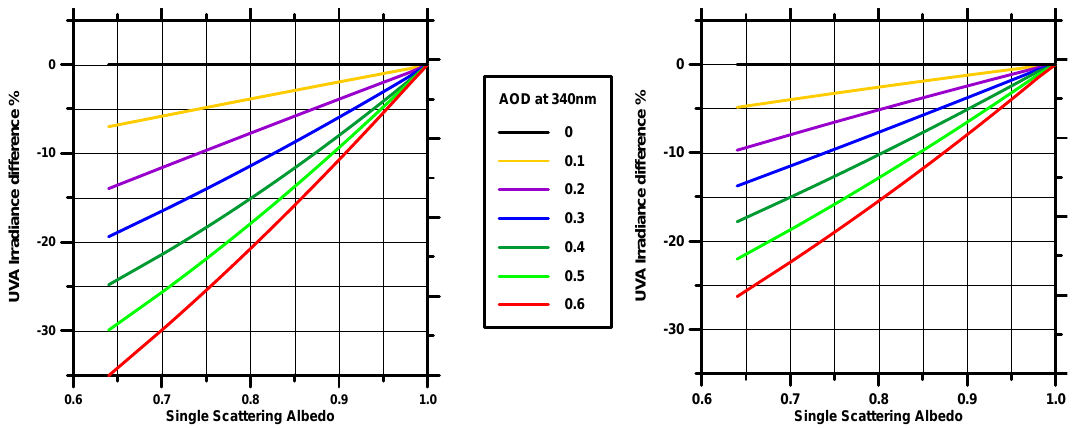
Fig. 1. Per cent irradiance difference from the irradiance using SSA=1 as a function of AOD’s for SZA’s of 60 ◦ (left) and 30 ◦ (right). Figure 1. Per cent irradiance difference from the irradiance using SSA =1 as a function of AOD’s for SZA’s of 60 o (left) and 30 o (right).